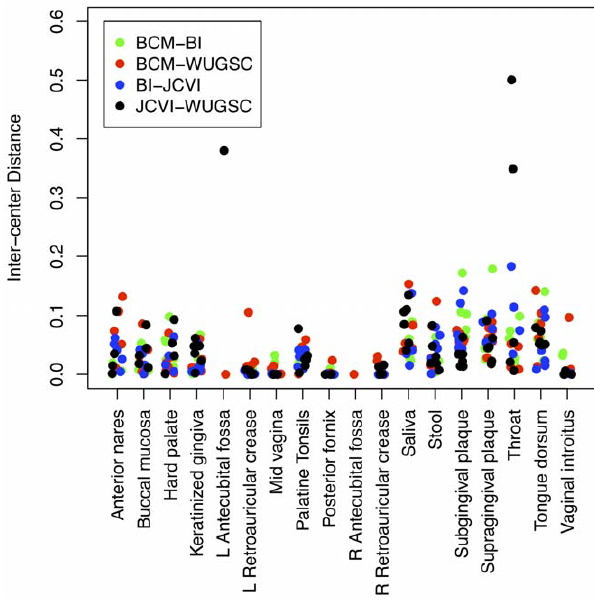
Figure 7. Pairwise ThetaYC distances between different DNA samples that were PCR amplified and sequenced at two different sequencing centers using the V13 region. The uneven distribution of points across body sites is due to the inability of the sequencing centers to generate more than 2,000 sequence reads for that sample.